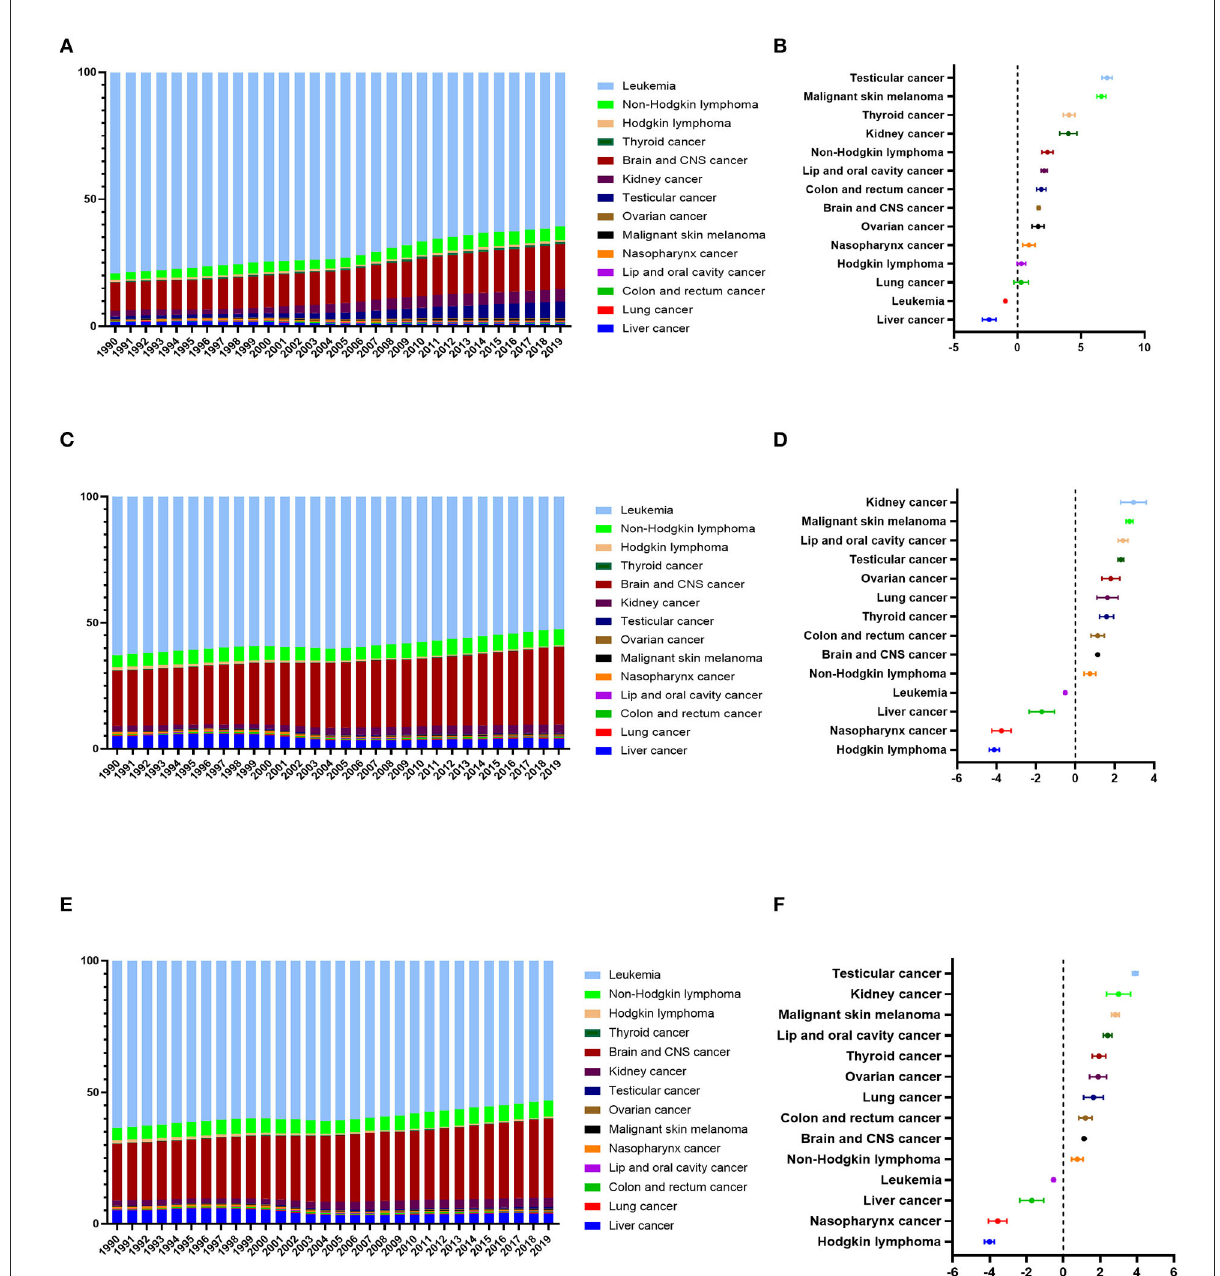
FIGURE1 Changes in the proportion of new cases, cancer deaths, and DALYs of all the childhood cancers in China from 1990 to 2019. (A) The proportion of new cases of all the childhood cancers in China from 1990 to 2019. (B) The average annual percentage change (AAPC) in the proportion of new cases of all the childhood cancers in China from 1990 to 2019. (C) The proportion of cancer deaths of all the childhood cancers in China from 1990 to 2019. (D) The average annual percentage change (AAPC) in the proportion of cancer deaths of all the childhood cancers in China from 1990 to 2019. (E) The proportion of DALYs of all the childhood cancers in China from 1990 to 2019. (F) The average annual percentage change (AAPC) in the proportion of DALYs of all the childhood cancers in China from 1990 to 2019.